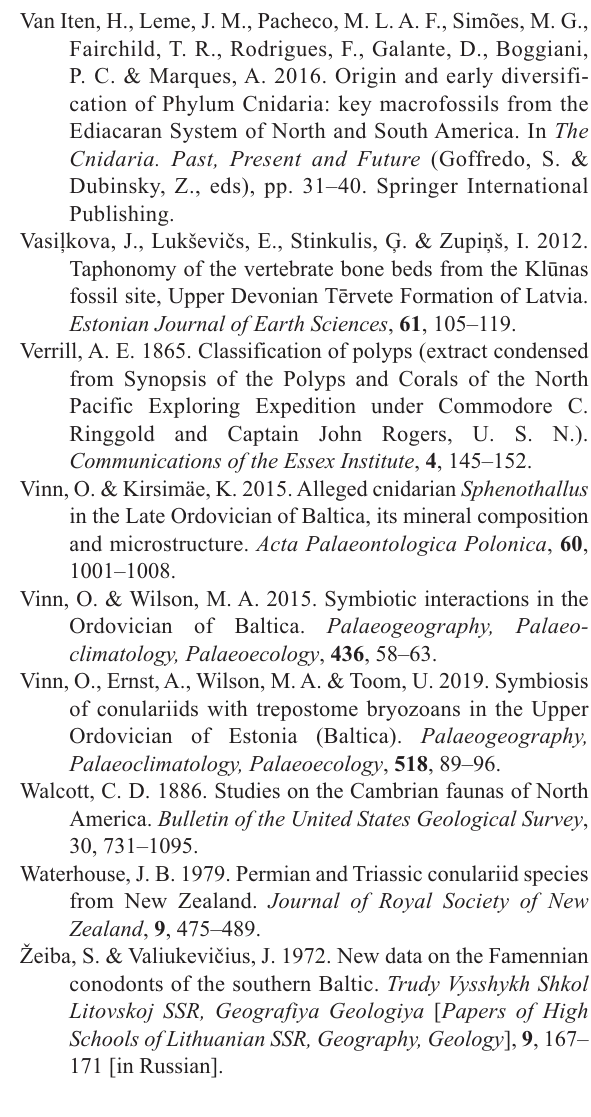
delta või estuaari